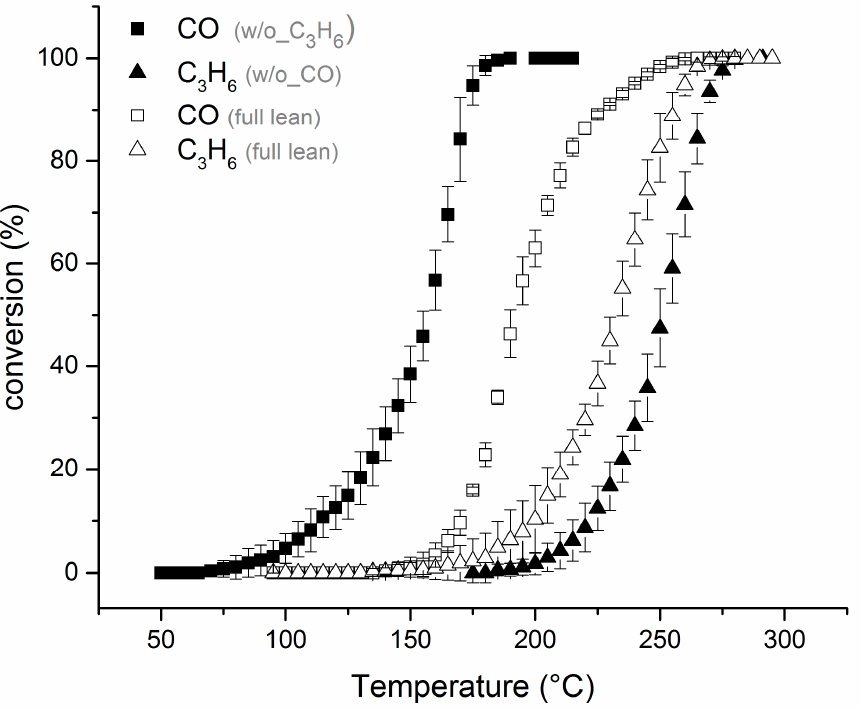
Figure 4. Separate CO and propylene (filled symbols) and full lean feed (CO + C 3 H 6 ; open symbols) oxidation measurement data as a function of temperature using 2 wt. % Pd/20 wt. % CeO 2 /Al 2 O 3 (Ce_Pd) as oxidation catalyst. The compositions of the feed gas mixtures are given in Table 1. In the following, the reactor filling changed to a layered two component